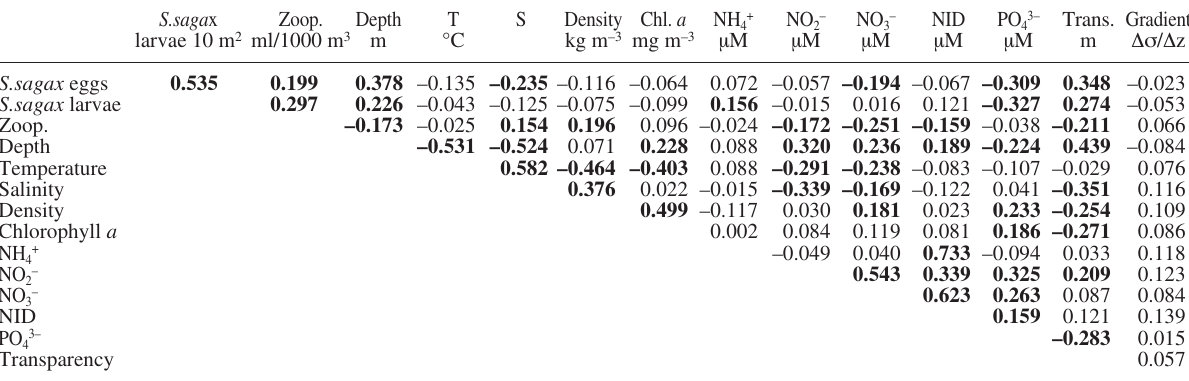
Bold numbers indicate singnificant differences between means (±95% confidence interval). Table 2. – Spearman’s rank order correlations between Sardinops sagax egg and larval abundance and hydrological variables during winter and early spring 2005–2009 in Bahía Magdalena, Baja California Sur. Chl. a , chlorophyll a ; S, salinity; T, temperature; Trans.,